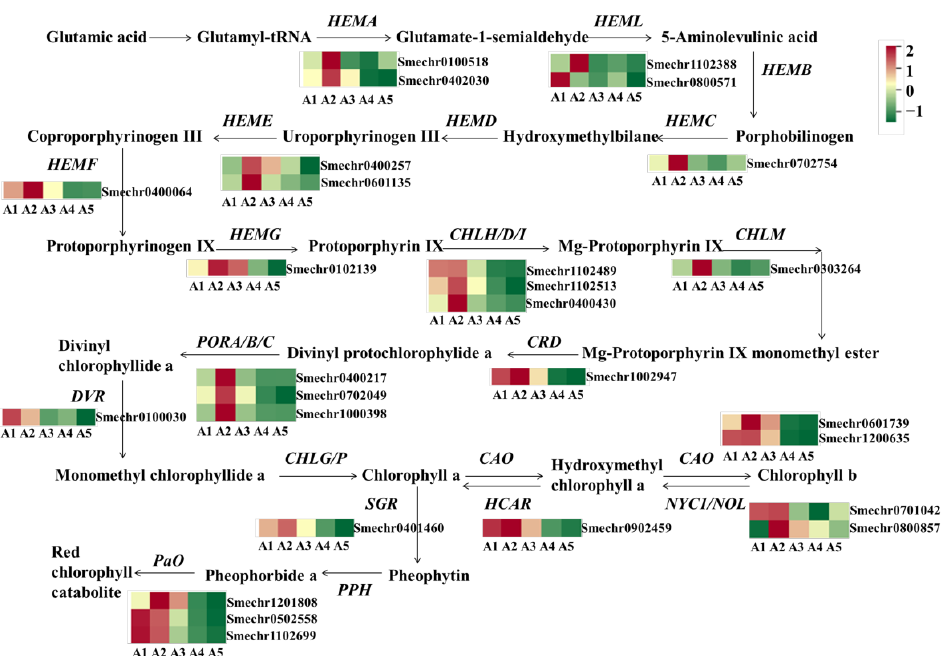
Figure 7. Differential expression of genes related to the chlorophyll metabolism pathway. HEMA, Glutamyl-RNA reductase; HEMB, Delta-aminolevulinic acid dehydratase; HEMC, Porphobilino- gen deaminase; HEME, Uroporphyrinogen decarboxylase; HEMF, Coproporphyrinogen-III oxi- dase; HEMG, Protoporphyrinogen III oxidase; CHLH/D/I, Magnesium-chelatase subunit ChlH/ChlD/ChlI; CHLM, Magnesium protoporphyrin IX methyltransferase; CRD, Magnesi- um-protoporphyrin IX monomethyl ester cyclase; DVR, Diviyl chlorophyllide a 8-vinyl-reductase; POR, Protochlorophyllide oxidoreductase; CHLG, Chlorophyll synthase; NYC1/NOL: Chlorophyll (ide) b reductase; CAO, chlorophyllide a oxygenase; HCAR, 7-hydroxymethyl chlorophyll a re- ductase; SGR, Stay-green; PPH, Pheophytinase; PaO, Pheophorbide a oxygenase; RCCR, Red Chl catabolite reductase.